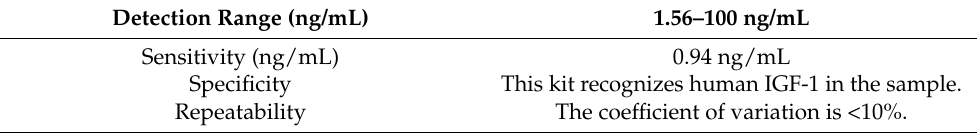
Table 2. Technical characteristics of IGF-1 ELISA kits produced by